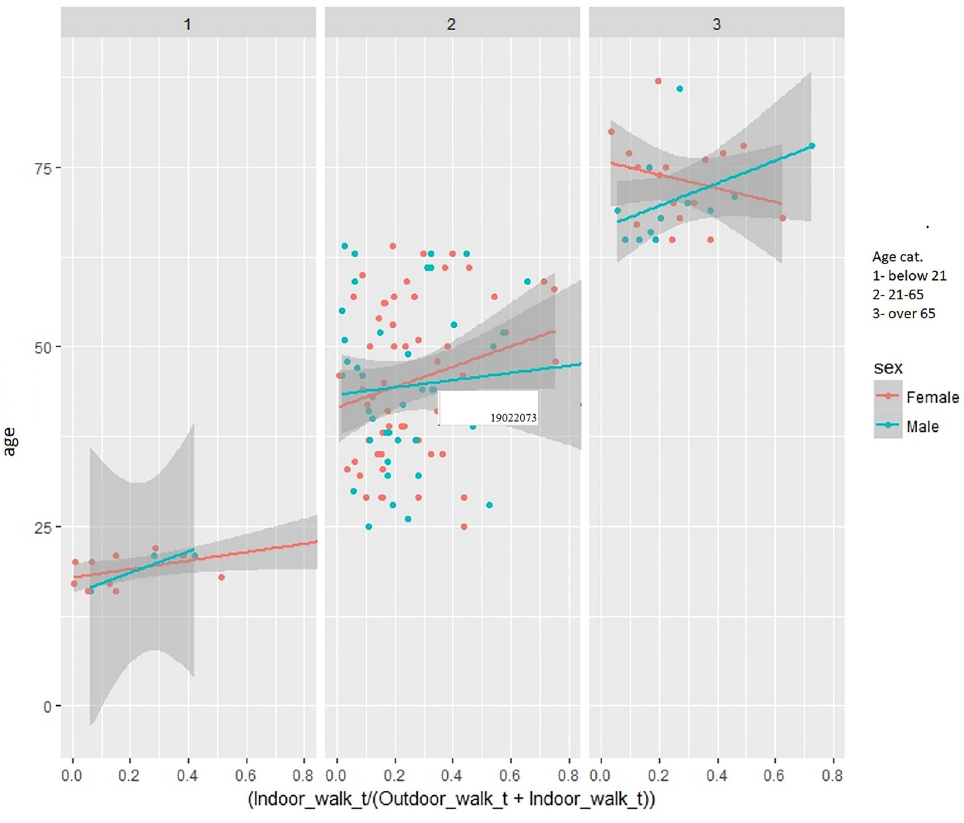
Fig 10. Percentage of indoor walking vs total walking per age group (1- under 25, 2–25–65 years old, 3–65+ years old).